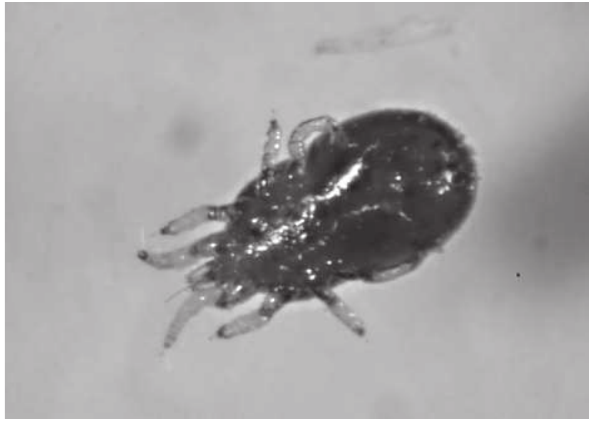
Fig. 1. – Gorged adult Dermanyssus gallinae . The chelicerae are